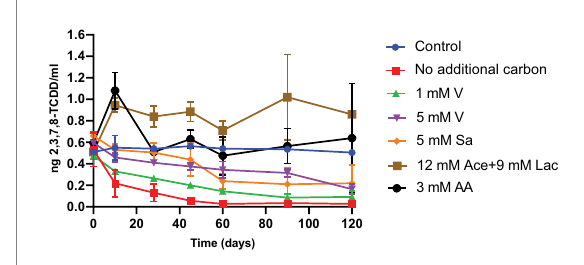
Degradation of 2,3,7,8-TCDD, as measured by the DR ® CALUX bioassay, over time in cultures containing different carbon and energy sources. 2,3,7,8-TCDD was dissolved in DMSO and added to culture flasks to a final concentration of 0.5 ng/ml. The DMSO concentration was 7 mM in all cultures. The error bar at each data point represents the standard deviation of two independent experiments. Blue circles, control incubations with dead cells obtained after heat inactivation at 121 ° C for 15 min (control); red squares, no additional carbon and energy sources; green triangles, 1 mM vanillin (1 mM V); purple triangles, 5 mM vanillin (5 mM V); orange diamonds, 5 mM sodium salicylate (5 mM Sa); brown squares, 12 mM sodium acetate and 9 mM sodium lactate (12 mM Ace +9 mM Lac); black circles, 3 mM amino acid including 1 mM tryptophan, 1 mM tyrosine and 1